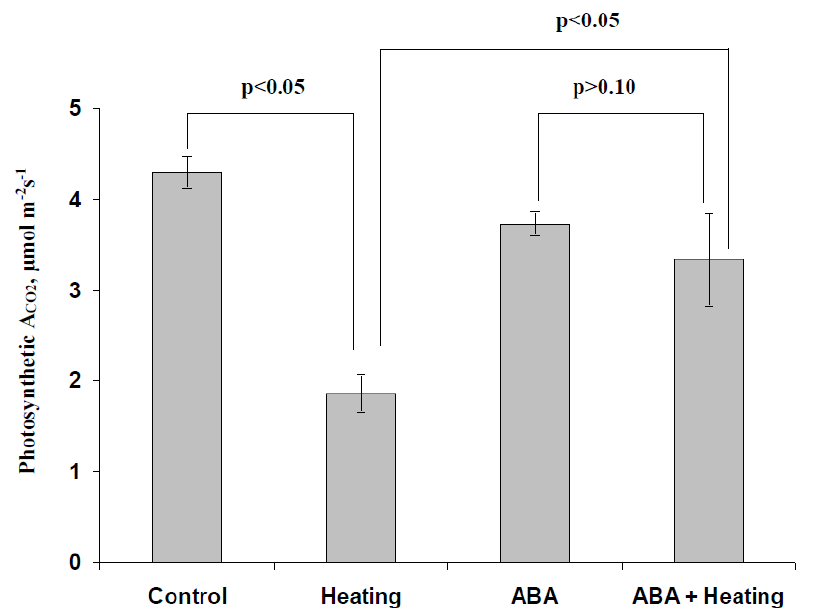
Figure 3. Influence of the ABA treatment on the photosynthetic assimilation of CO 2 (A CO2 ) after heating in pea seedlings ( n = 5–15). The ABA treatment of seedlings was performed by spraying them with aqueous solutions (10 −5 M) 1 day before heating; plants without the ABA treatment were treated with equal volumes of water. Seedlings were heated from between 23 and 24 °C to 48 °C for 30 min using a thermostat. The photosynthetic CO 2 assimilation was measured after 10 min of illumination by blue actinic light (239 µmol m −2 s −1 ); photosynthetic measurements were performed 1 day after heating in the second mature leaf.